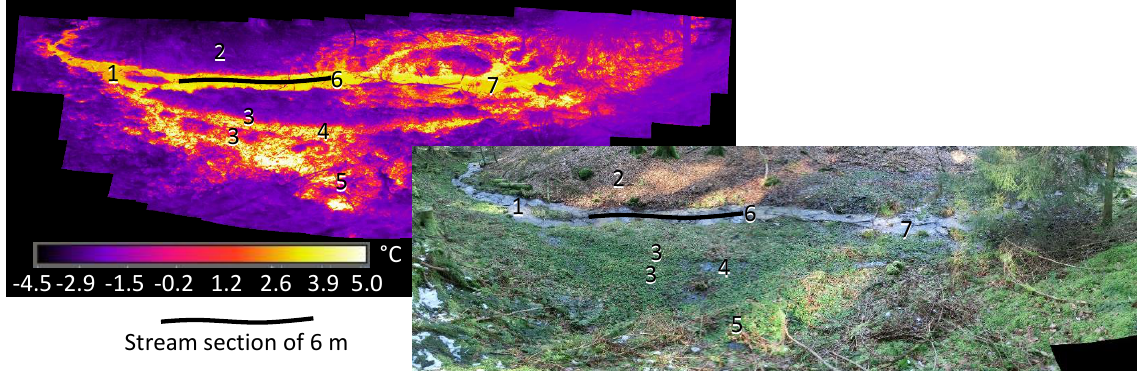
Figure 1. TIR image and VIS image of a riparian-stream zone. The temperature contrast between the water and the surrounding environment allows us to clearly differentiate between surface-saturated and dry areas in the TIR image. The numbers indicate identical locations in the TIR and VIS images and relate to dry areas (2), stream water (1, 4, 6), points of supposed groundwater exfiltration (5, 7: warmer water temperatures), and locations in which surface saturation is clearly visible in the TIR image but not in the VIS image (3, area above